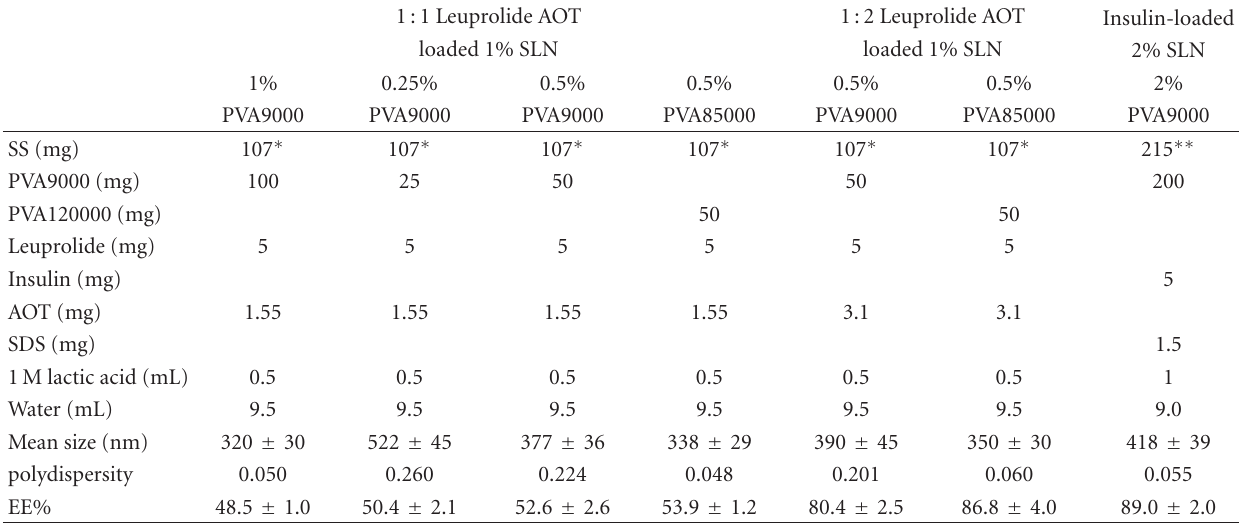
Table 1: SLN composition, mean diameter, and EE%.